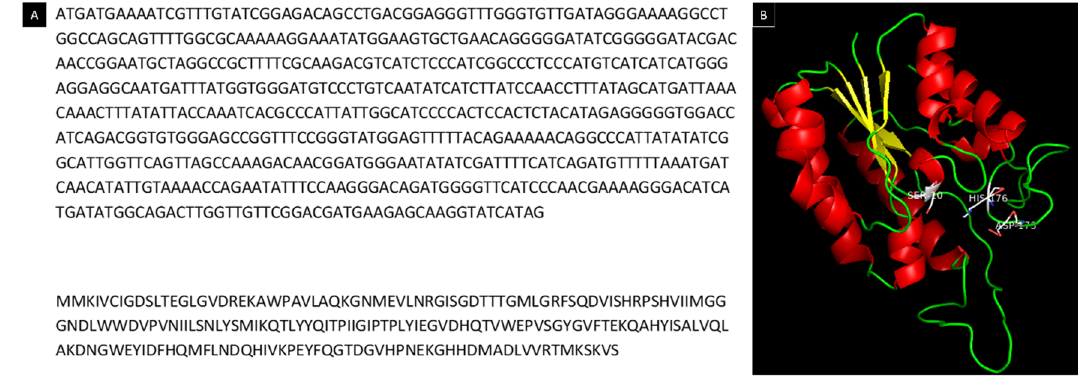
Figure 2. DNA and protein sequences and model of LipB12_A11. ( A ) DNA sequence and translated protein sequence of the DNA conferring lipolytic activity. ( B ) Predicted model of the lipolytic protein LipB12_A11 generated using SWISS-MODEL and visualized with PyMOL using a putative lipolytic protein of the G-D-S-L family from Desulfitobacterium hafniense (SMTL ID 4rsh.1.A) as the template. Secondary structures are highlighted in color with α -helices in red, β -sheets in yellow, and ribbons in green. The catalytic triad residues are highlighted (SER10, ASP173, and HIS176).